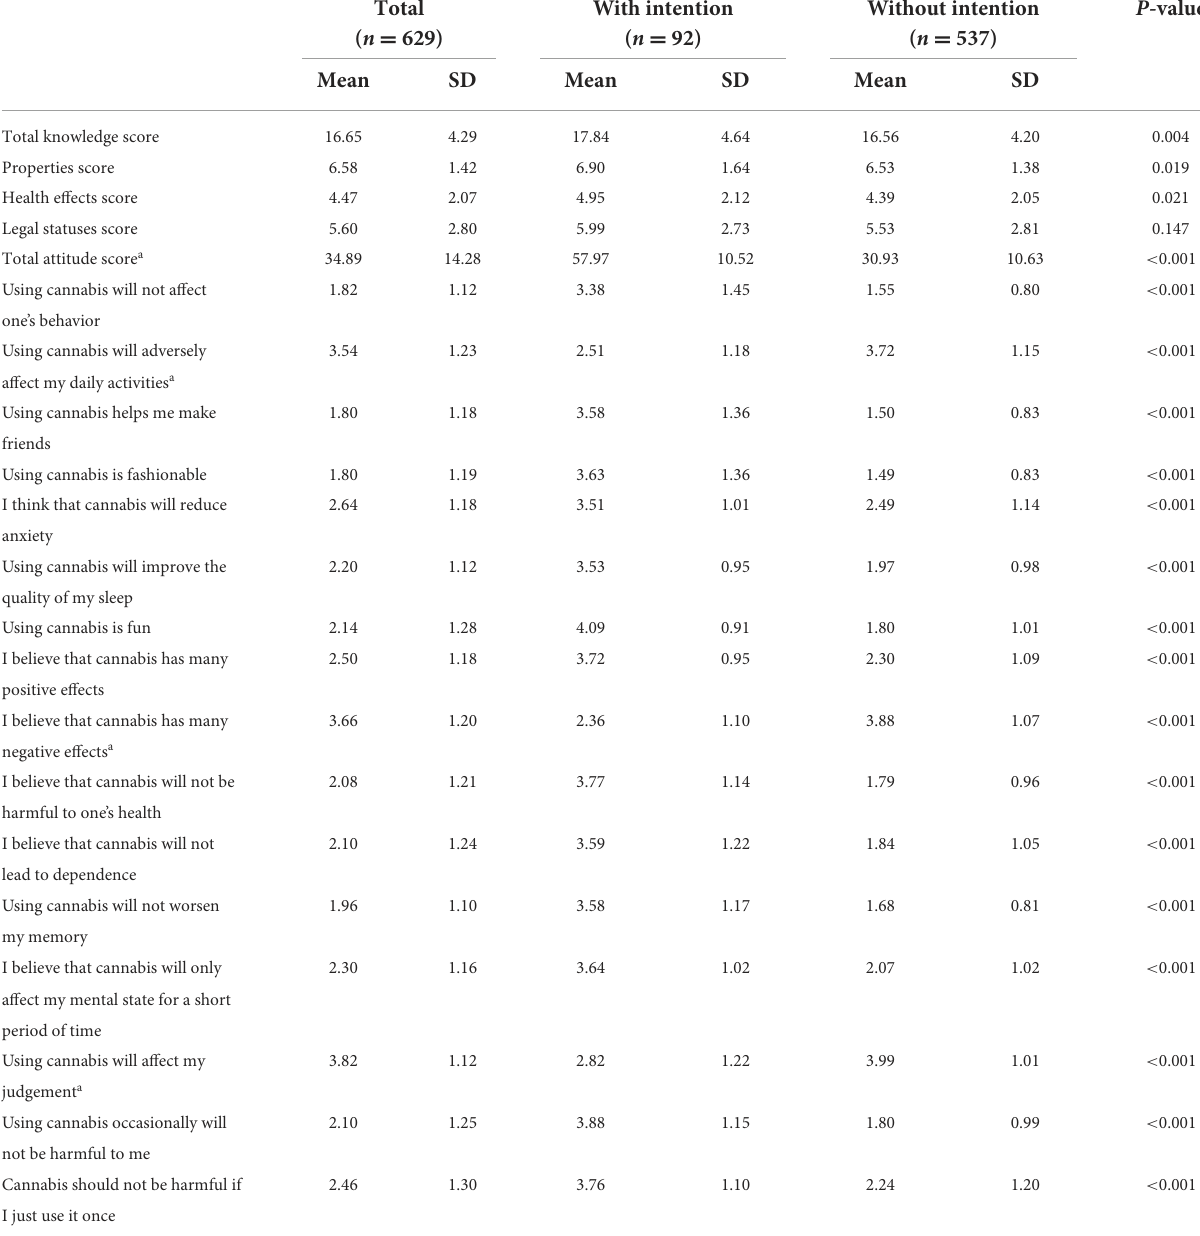
TABLE 2 Cannabis knowledge and attitude of respondents stratified by intention. Total With intention Without intention P -value ( n = 629) ( n = 92) ( n = 537) Mean SD Mean SD Mean